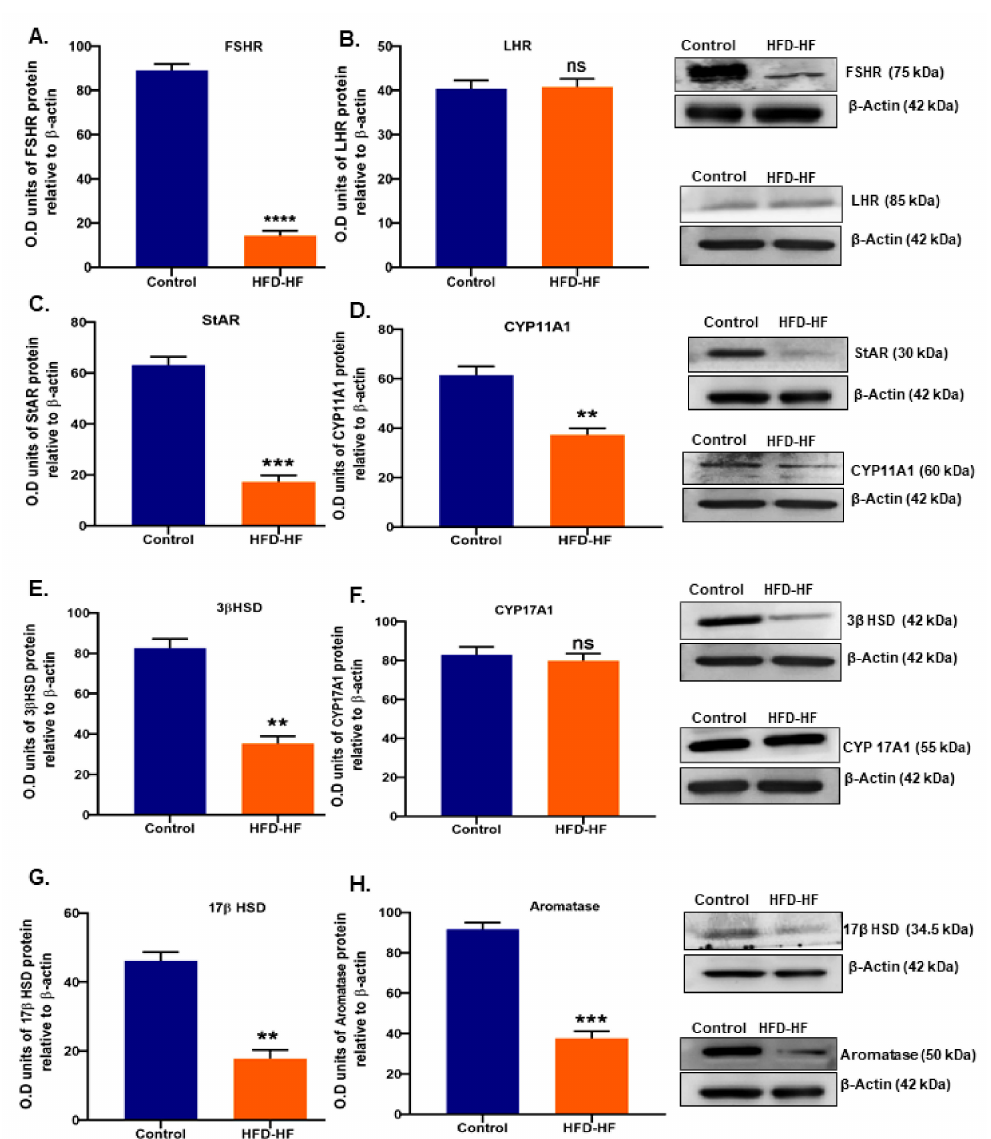
Figure 5. Effects of the HFD-HF diet on the expression level of ( A ) FSHR, ( B ) LHR, ( C ) StAR, ( D ) CYP11A1, ( E ) 3 β HSD, ( F ) CYP17A1, ( G ) 17 β HSD, and ( H ) P450 aromatase in the ovaries of rats fed on the HFD-HF diet. Each value is mean ± SEM of three samples of pooled cells from six animals from each group. Bars with ns denote statistically insignificant differences between the respective means, while those (**, ***, ****) signs represent statistically significant differences (** p ≤ 0.01, *** p ≤ 0.0001, **** p ≤ 0.0001 vs. control group) between the respective